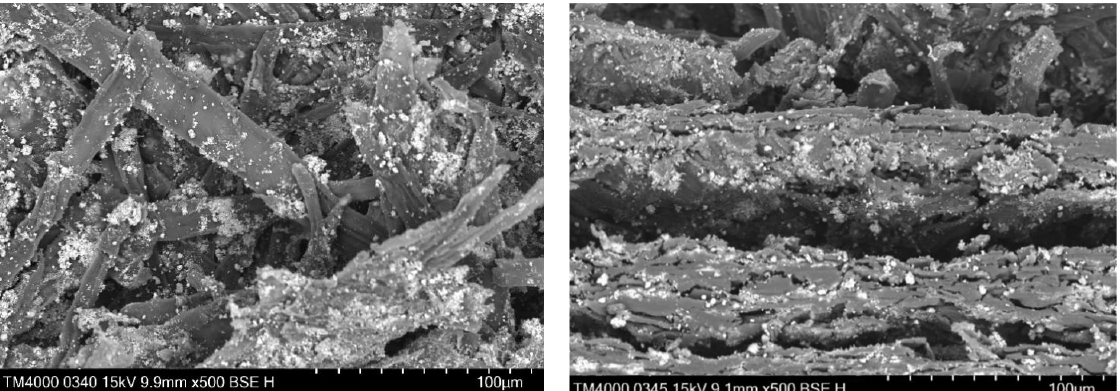
Figure 1. X-ray diffraction spectra of the solid residues of the process of the alkaline oxidation of flax shives catalyzed by CuSO 4 . Stirring speeds, rpm: 1—400, 2—500, 3—700. Red and blue numbers are of Cu 2 O and CuO reflections, respectively.